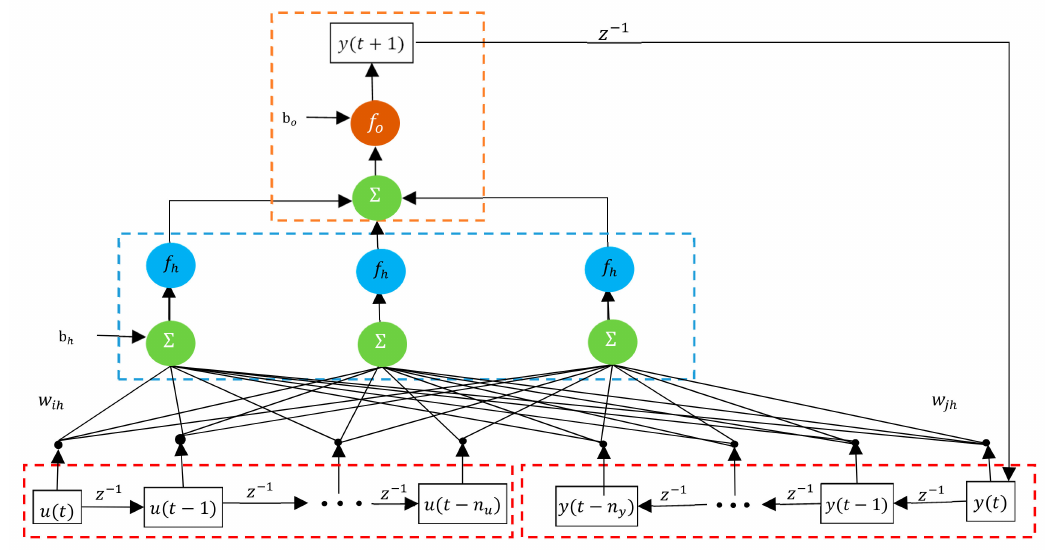
Figure 2. Schematic diagram of